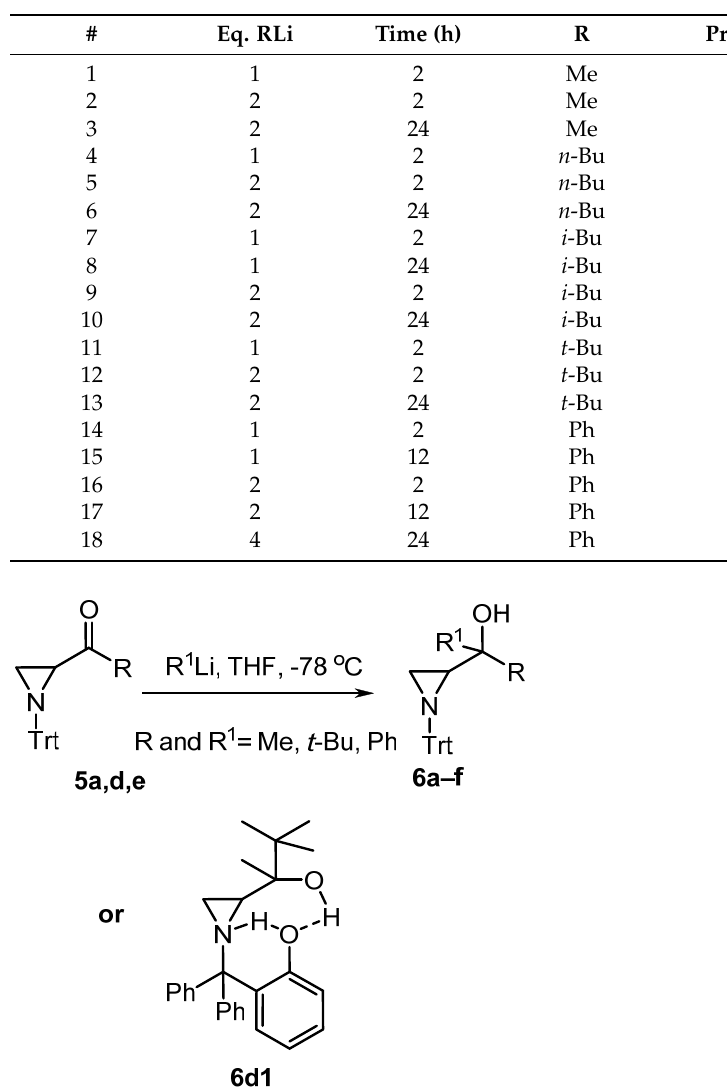
Figure 2. Crystal X-ray structure of carbinol 6d1 . Reactions of organolithiums with both electron-rich Trt (substrates 4a , Scheme 2, Ta- ble 2) and electron-deficient Boc (substrate 4b , Scheme 4, Table 4) N-substituents contain- ing dimethylamides were found to be regioselective (Table 4, entries 1–5). No side reac- tions at the aziridine ring system were observed. However, in the reaction of amide 4b